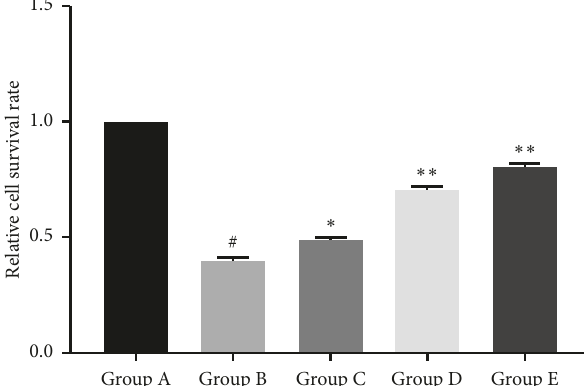
Figure 2: Relative cell survival rate in M¨uller cells. The cells were treated as described in Figure 1 and then incubated with MTT to determine the relative survival rate. # P < 0 . 0001, compared with Group A (0mmHg additional pressure); ∗ P < 0 . 0005 and ∗∗ P < 0 . 0001, compared with Group B (60 mmHg additional pressure). Data from one experiment are shown as a representative of three studies performed under the same conditions. Group A: 0 mmHg; Group B: 60mmHg; Group C: 60mmHg + 10 μ mol/L cyanin chloride; Group D: 60mmHg + 30 μ mol/L cyanin chloride; Group E: 60mmHg + 50 μ mol/L cyanin